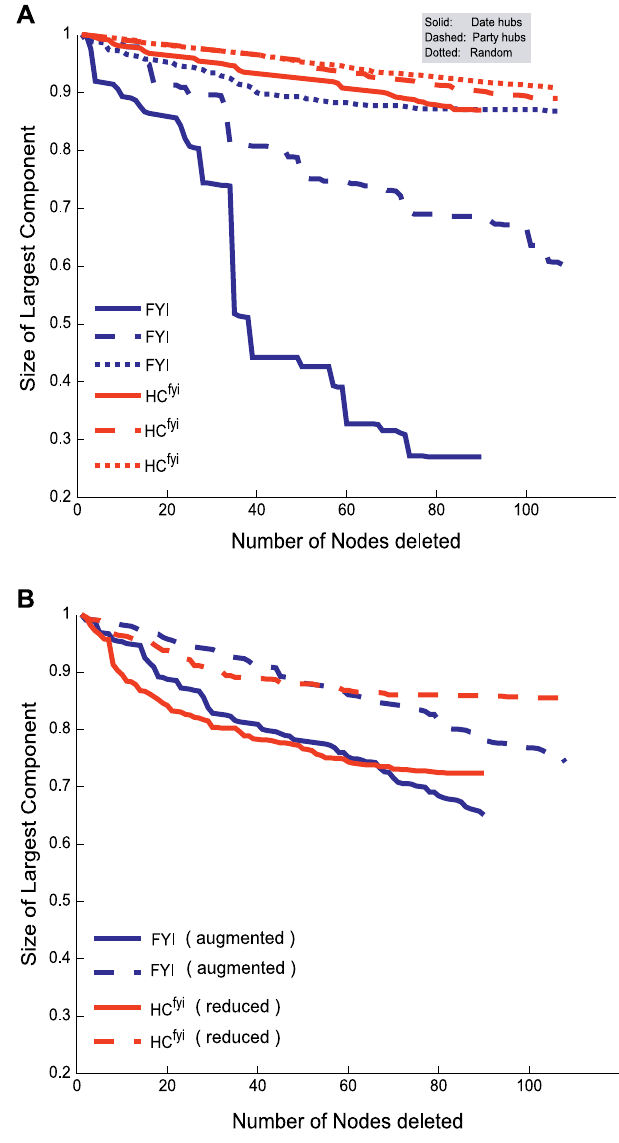
Figure 4. Network Tolerance to Hub Deletion The size of the largest component after deletion of hubs in the indicated networks was normalized by the initial size of the largest component. In all cases, hubs were deleted in descending order of connectivity. (A) The FYI network is sensitive to hub deletions, whereas the HC fyi network is tolerant to hub deletions. (B) Topological sensitivity to node deletion can be modulated by varying the fraction of hub–hub interactions. Addition of 10% of random hub– hub interactions is sufficient to increase the tolerance of the FYI network to hub deletion ( ‘‘ augmented ’’ ). Deletion of 40% of interactions among hubs is necessary to increase the sensitivity of the HC fyi network to hub deletion ( ‘‘ reduced ’’ ). DOI: